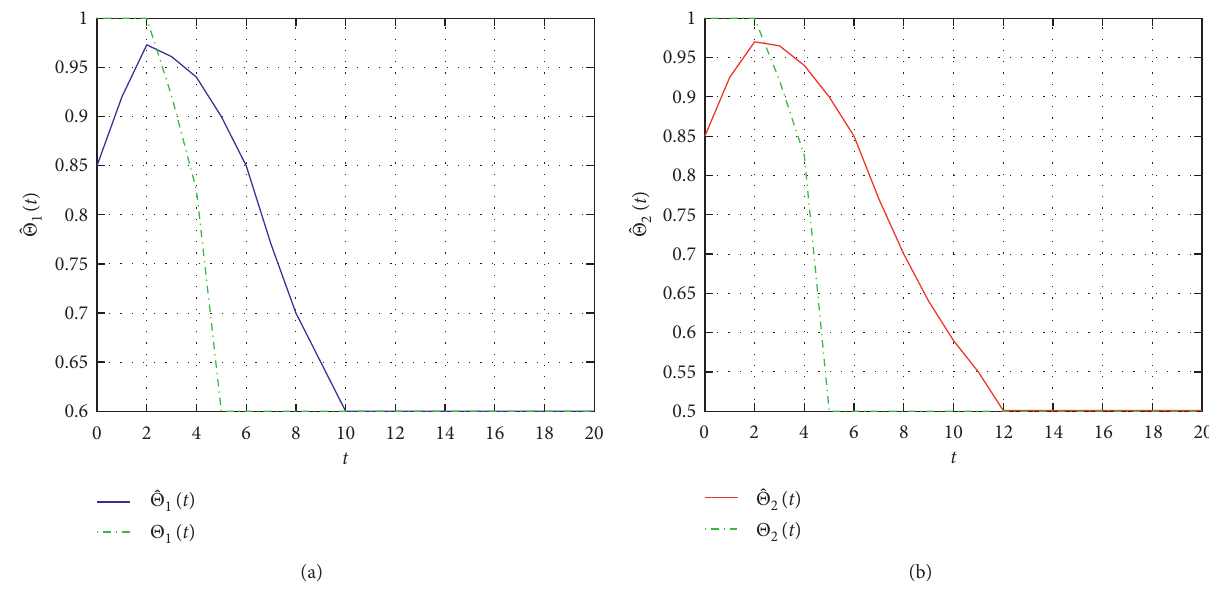
Figure 10: Actuator partial fault efficiency factors and the